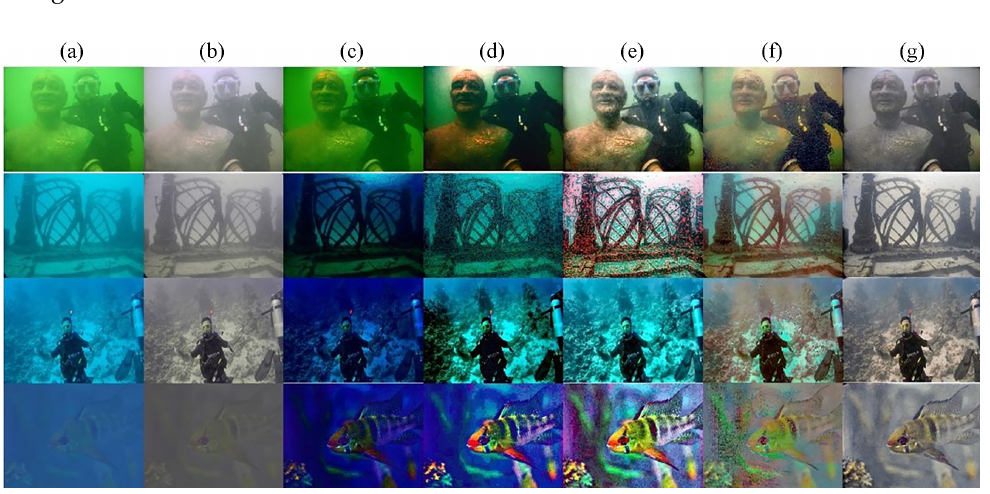
Figure 8. Comparison of different underwater image enhancement methods. ( a ) Original. ( b ) Simple white balance. ( c ) Underwater dark channel. ( d ) Multi-scale fusion. ( e ) DN-based. ( f ) UGAN. ( g )